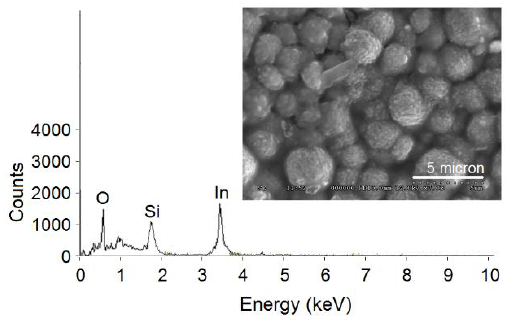
Figure 3. FE-SEM and EDX analyses of the synthesized In 2 O 3 nanoparticles.